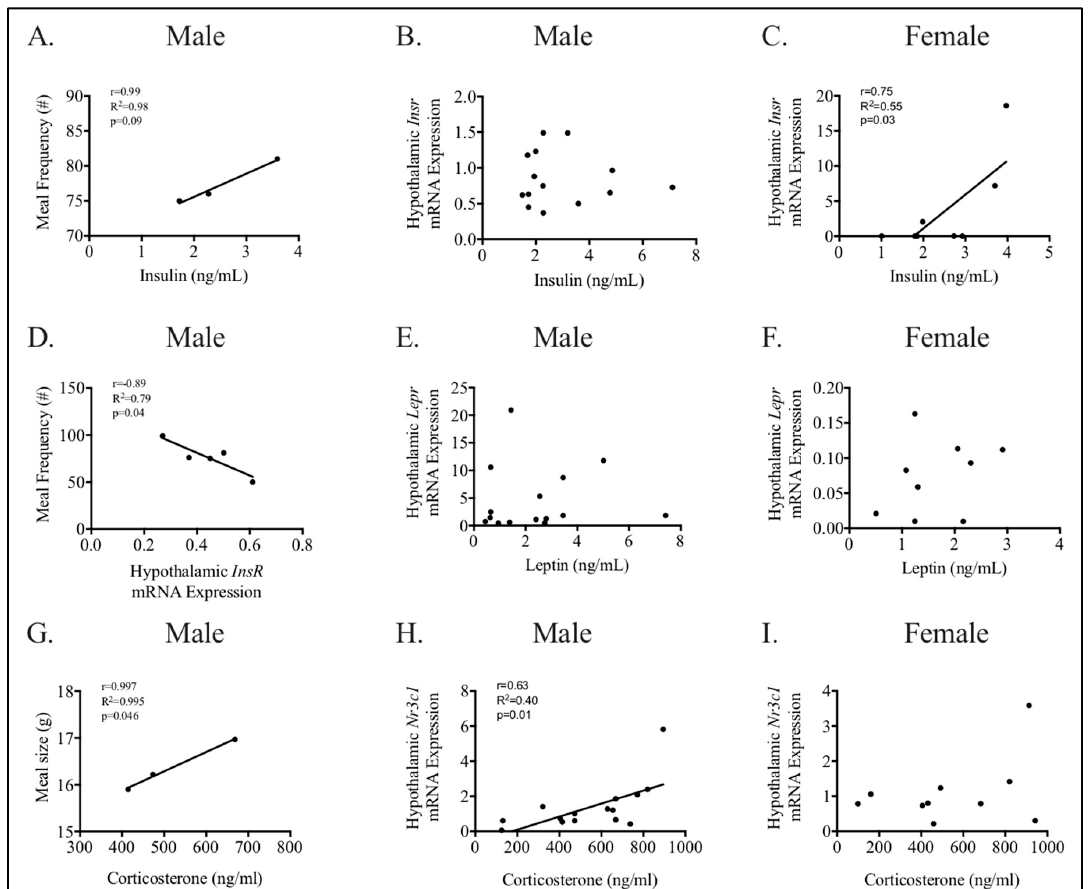
Figure 7. Relationships between appetite, peripheral hormones, and hypothalamic receptors are di ff erent between peripubertal males and females. Appetite was measured using metabolic chambers to determine meal size and frequency ( A , D , G ). Male meal frequency correlated with hypothalamic mRNA expression of insulin receptor ( D ) and trended towards correlation with fasted plasma insulin ( A ). Fasted male plasma corticosterone was directly and strongly correlated with meal size ( G ). Relationships between peripheral hormones and respective hypothalamic receptors involved in appetite were determined in males ( B , F , H ) and females ( C , F , I ). Male corticosterone and hypothalamic glucocorticoid ( Nr3c1 ) mRNA expression were strongly and directly correlated ( H ). Fasted male insulin ( B ) and leptin ( E ) did not correlate with mRNA expression of their respective hypothalamic receptors. Female fasted plasma insulin directly and strongly correlated with mRNA expression of the hypothalamic insulin receptor ( C ). Fasted female leptin ( F ) and corticosterone ( I ) did not correlate with mRNA expression of their respective hypothalamic receptors. Results are expressed as correlation coe ffi cient ( r ) and linear regression (R 2 ); p < 0.05 was considered significant; n = 3–5 ( A , C , G ), n = 13–15 ( B , E , H ); n = 7–10 ( C , F , I ); Insr —insulin receptor; Lepr —leptin receptor, and Nr3c1 —glucocorticoid